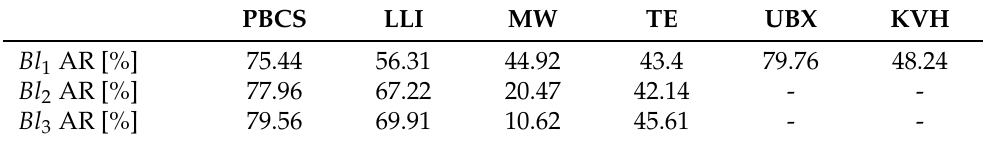
Table 10. Ambiguity resolution success ratios of the different solutions—Case Study